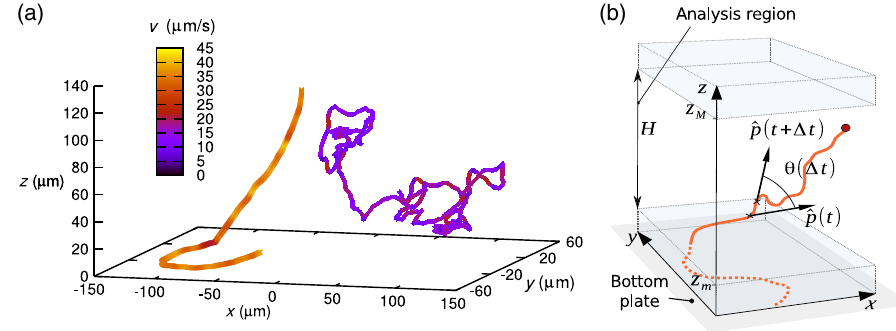
FIG. 1. Lagrangian 3D tracking of bacteria and analysis conditions. (a) RP437 wild-type E. coli displaying very different typical trajectories: persistent trajectory (bact 1: τ p ¼ 12 s) and nonpersistent trajectory (bact 2: τ p ¼ 0 . 7 s). (b) Sketch of the part of the track used for analysis and angles used for computing C ð Δ t Þ ¼ h ˆ p ð t Þ · ˆ p ð t þ Δ t Þi ¼ h cos θ ð Δ t Þi , using a sliding window for an average on time t .